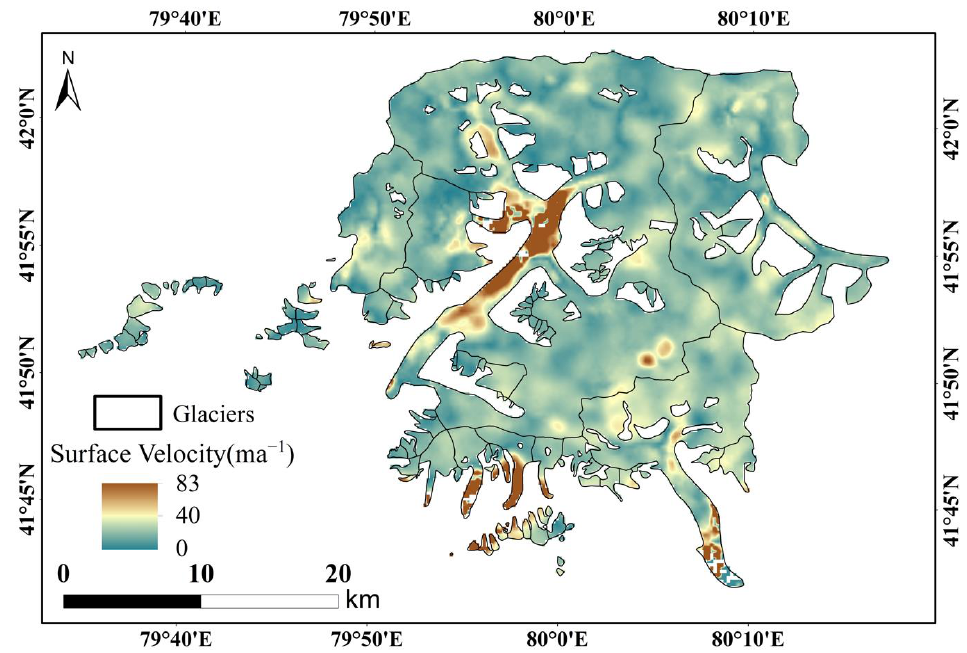
Figure 5. Distribution of glacier movement velocity in 2008 and 2009.